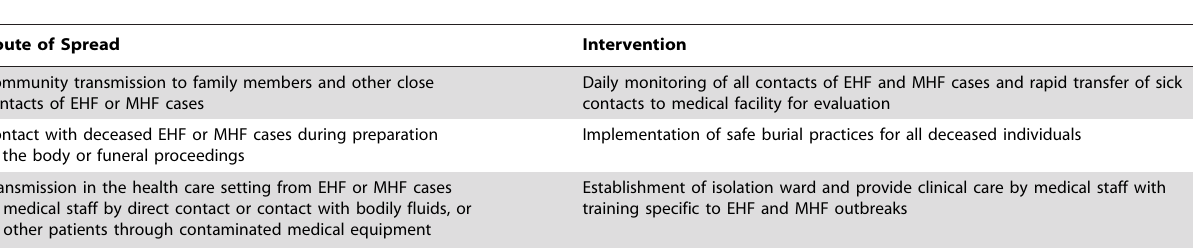
Table 1. Common routes of EHF and MHF spread, and interventions to stop transmission during outbreaks.